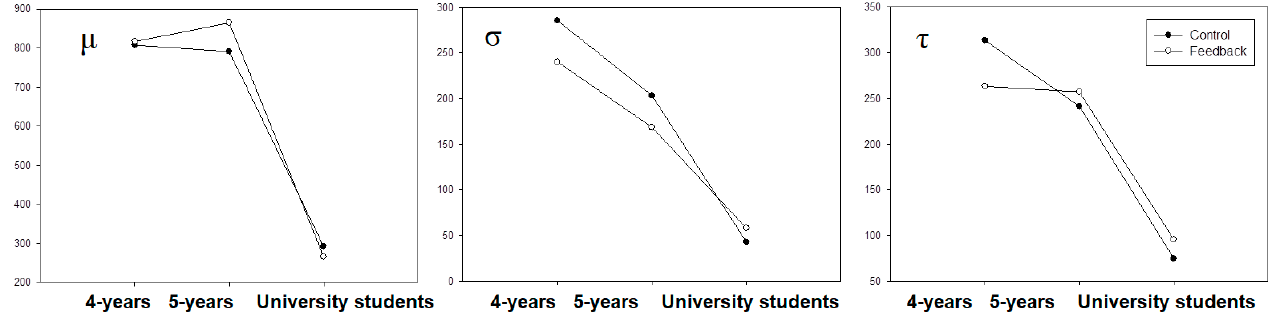
Figure 2. Differences between age groups in terms of